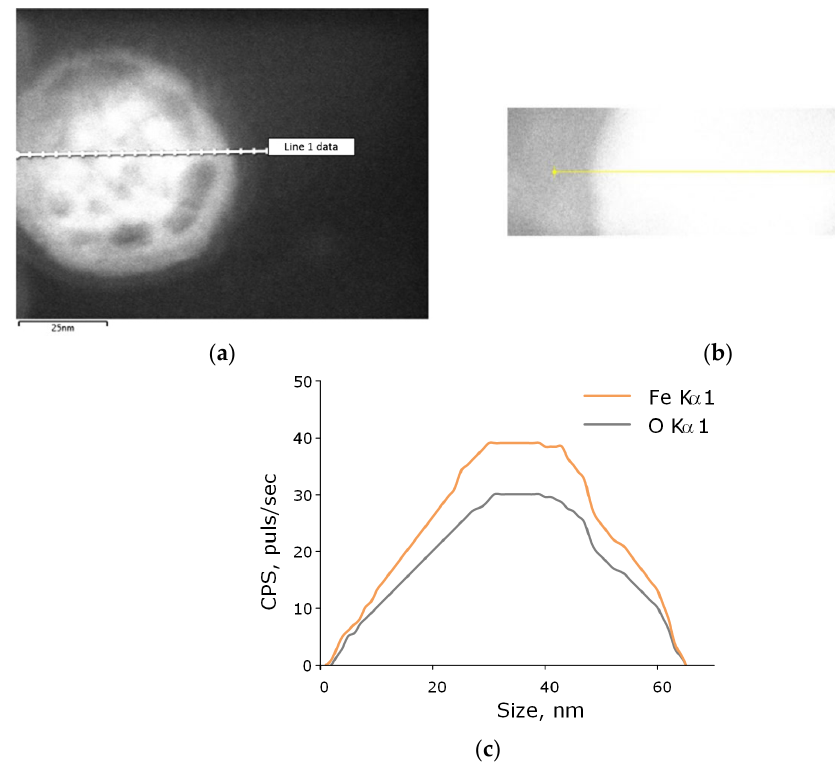
Figure 2. Elemental analysis of iron oxide NPs. ( a ) TEM image of a single iron oxide NP, analysis section is indicated by line 1. ( b ) Enlarged measurement site. ( c ) Nanoparticle profile by Fe K α 1 and O K α 1.